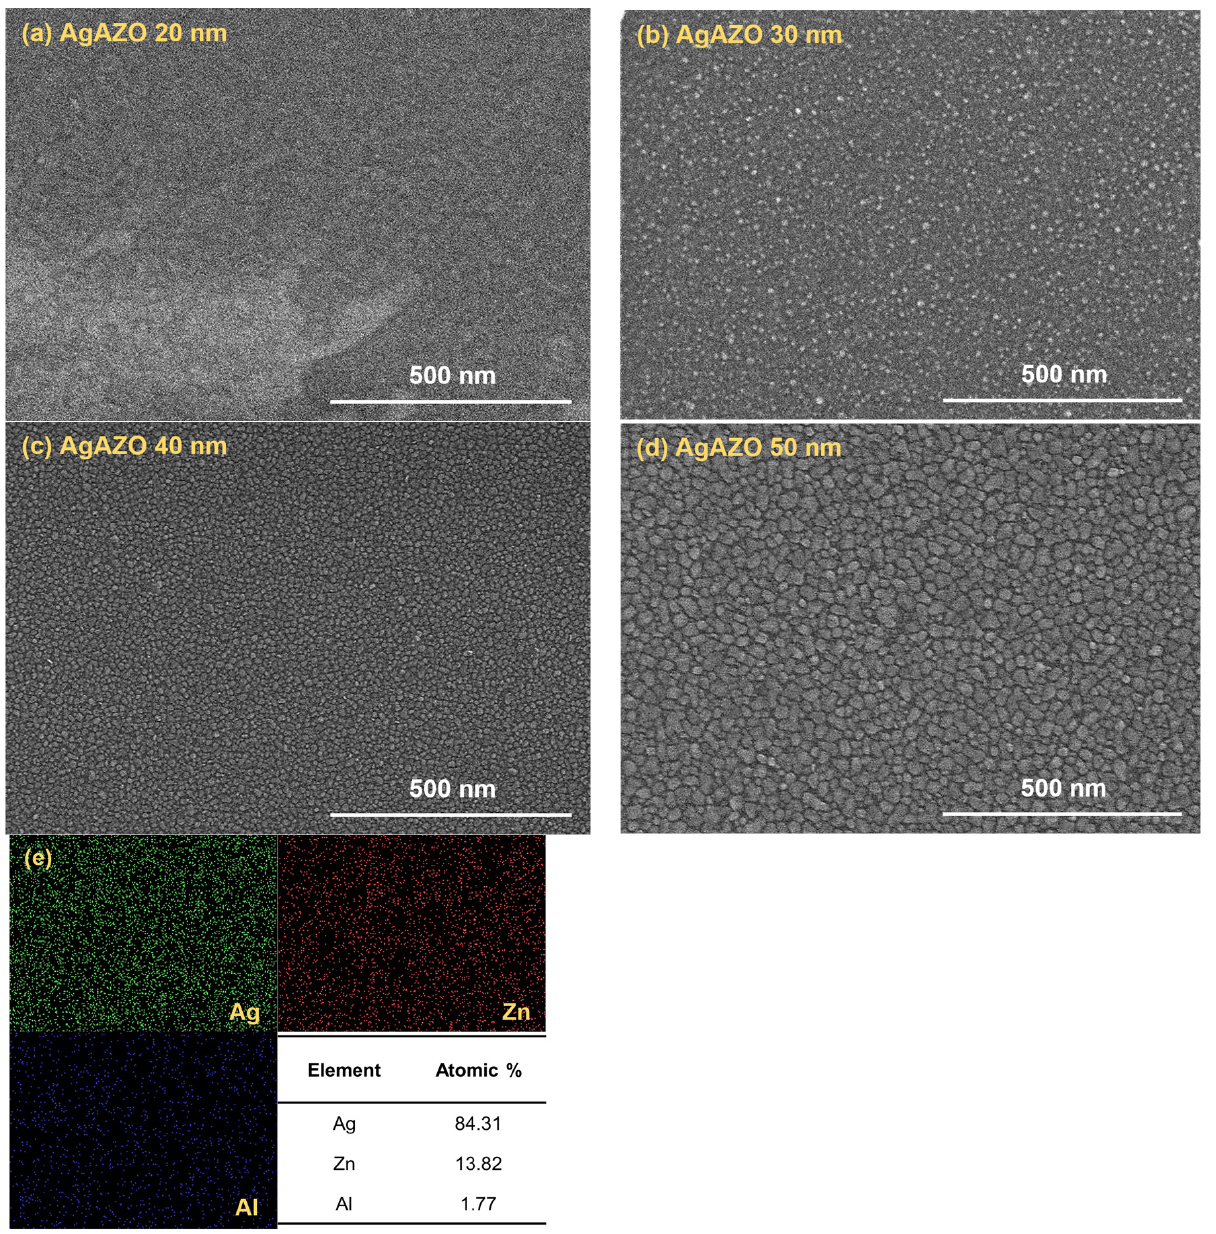
Figure 1. Thickness-dependent SEM images of Ag:AZO thin films. ( a ) 20 nm; ( b ) 30 nm; ( c ) 40 nm; ( d ) 50 nm; ( e ) EDX image of 20 nm Ag:AZO thin film.